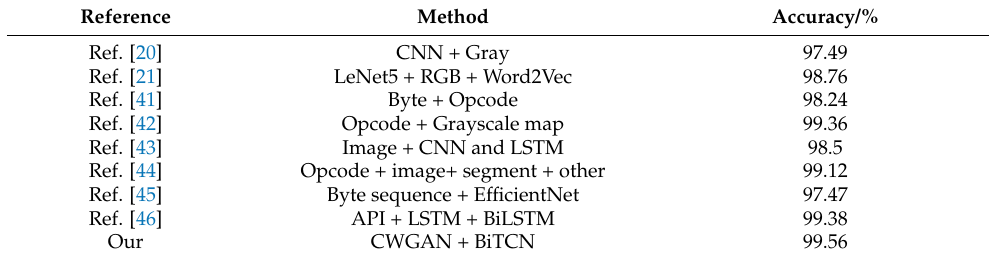
Table 11. Detection accuracy under the influence of difference algorithms on Kaggle dataset.